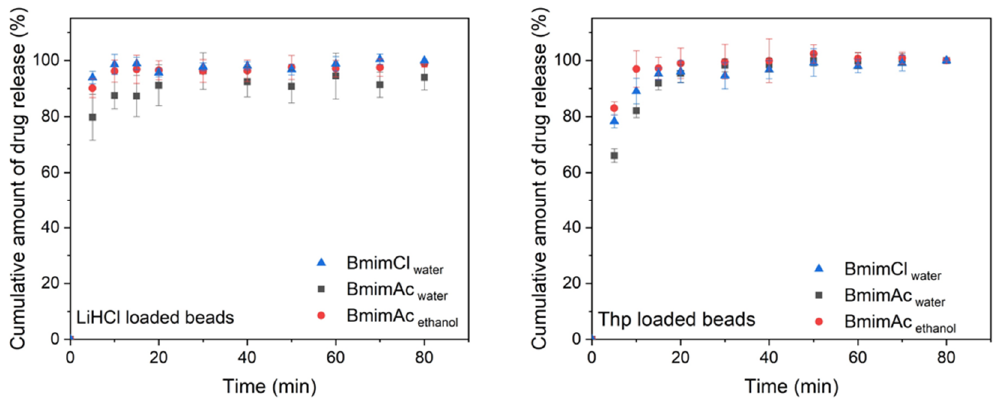
Figure 3. Loading capacities of cellulose beads prepared from waste denim. Figure 4. In vitro drug release curves for cellulose beads prepared from waste denim. Table 4. Swelling capacities of cellulose beads prepared from waste denim.